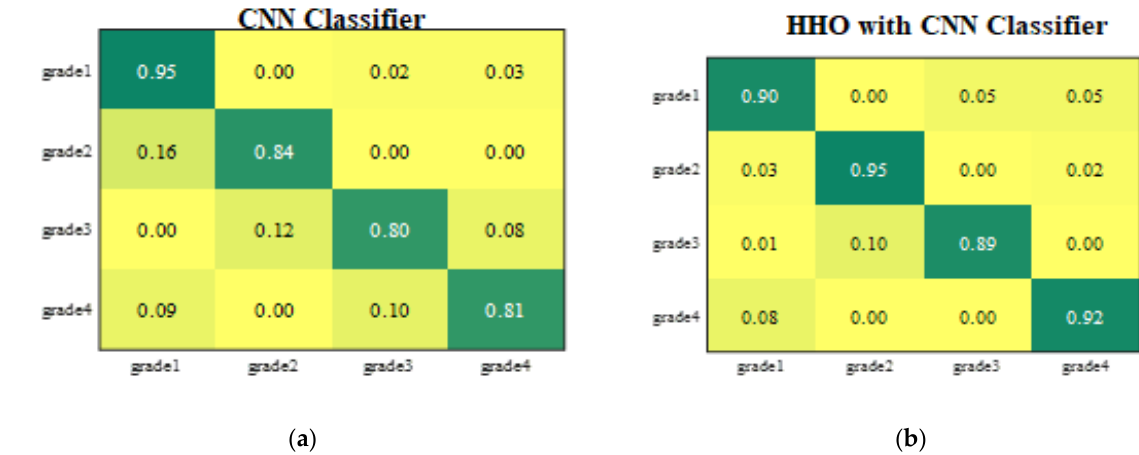
Figure 9. ( a ) Confusion matrix without optimization. ( b ) Confusion matrix with optimization.